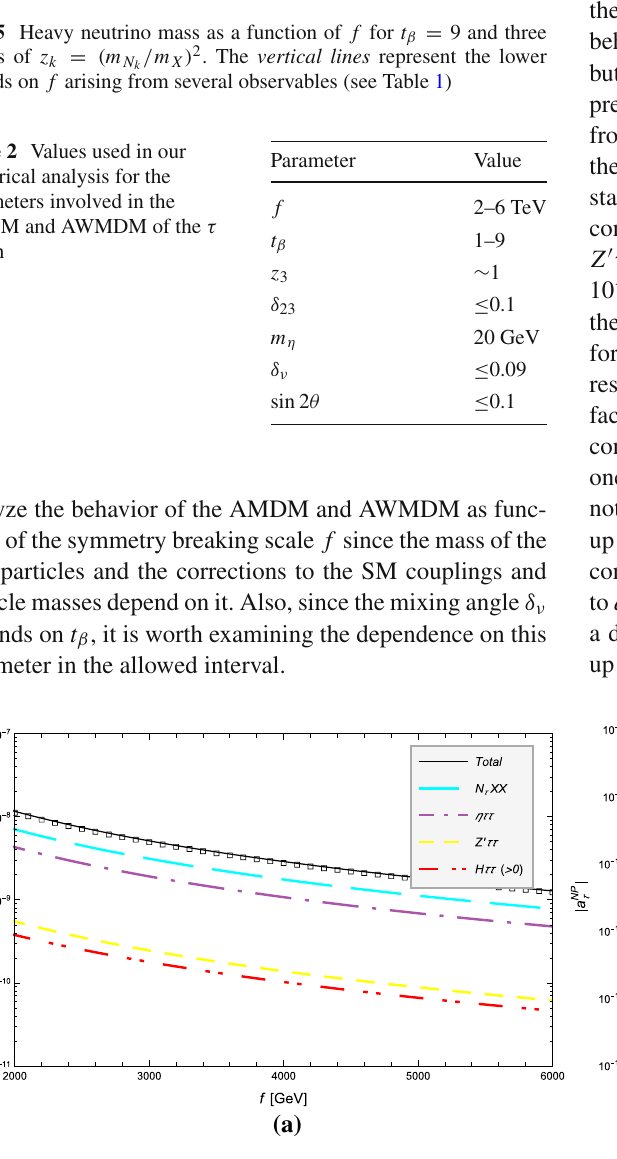
Fig. 6 Absolute values of the main partial contributions from the SLHM to a NP τ as functions of f for t β = 9 ( left plot ) and as func- tions of t β for f = 4 TeV ( right plot ). For the remaining parameters of the model we use the values shown in Table 2. The partial contributions